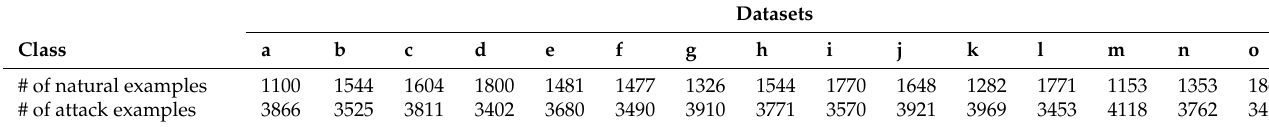
Table 1. The characteristics of the power grid datasets w.r.t. the number of samples that belong to attack or natural class.